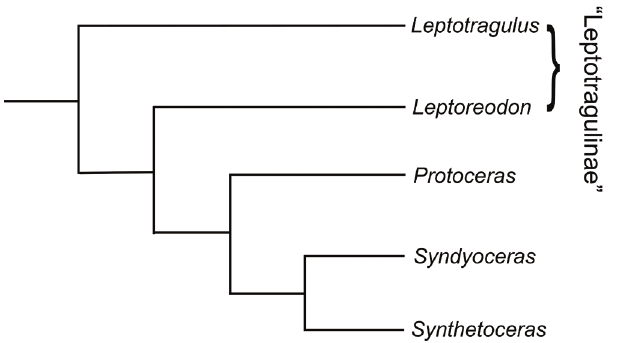
Figure 1. Hypothesized intrafamilial relationships of relevant Protoceratidae, based on Prothero